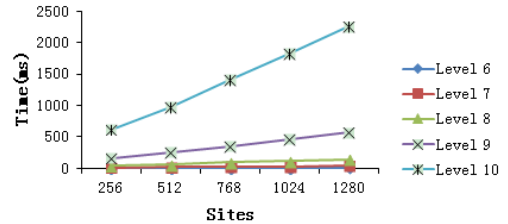
Figure 5. The influence of the amount of the input